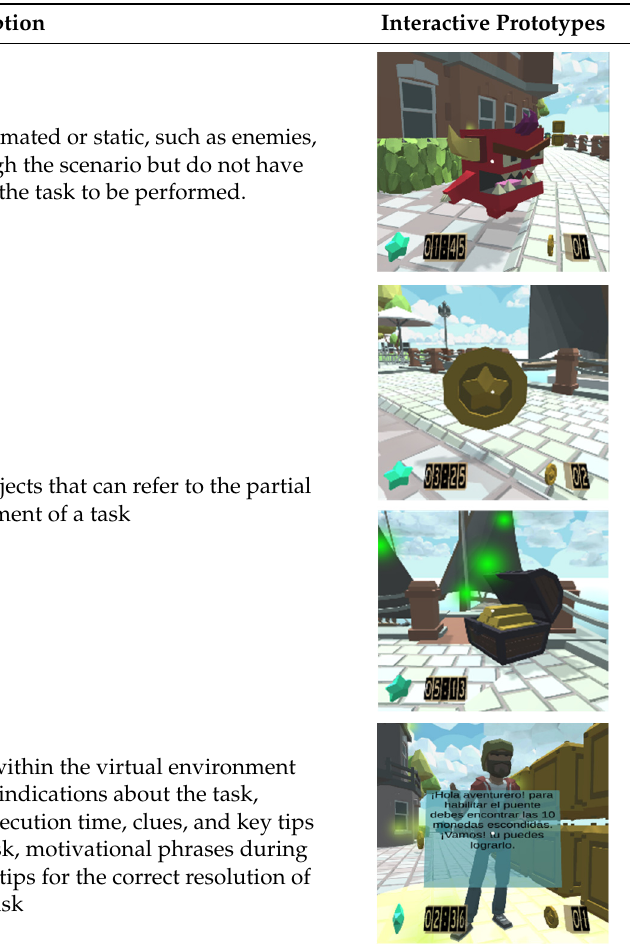
12 of 23 Table 5. Interactive prototypes for the virtual environment Attention-VR.